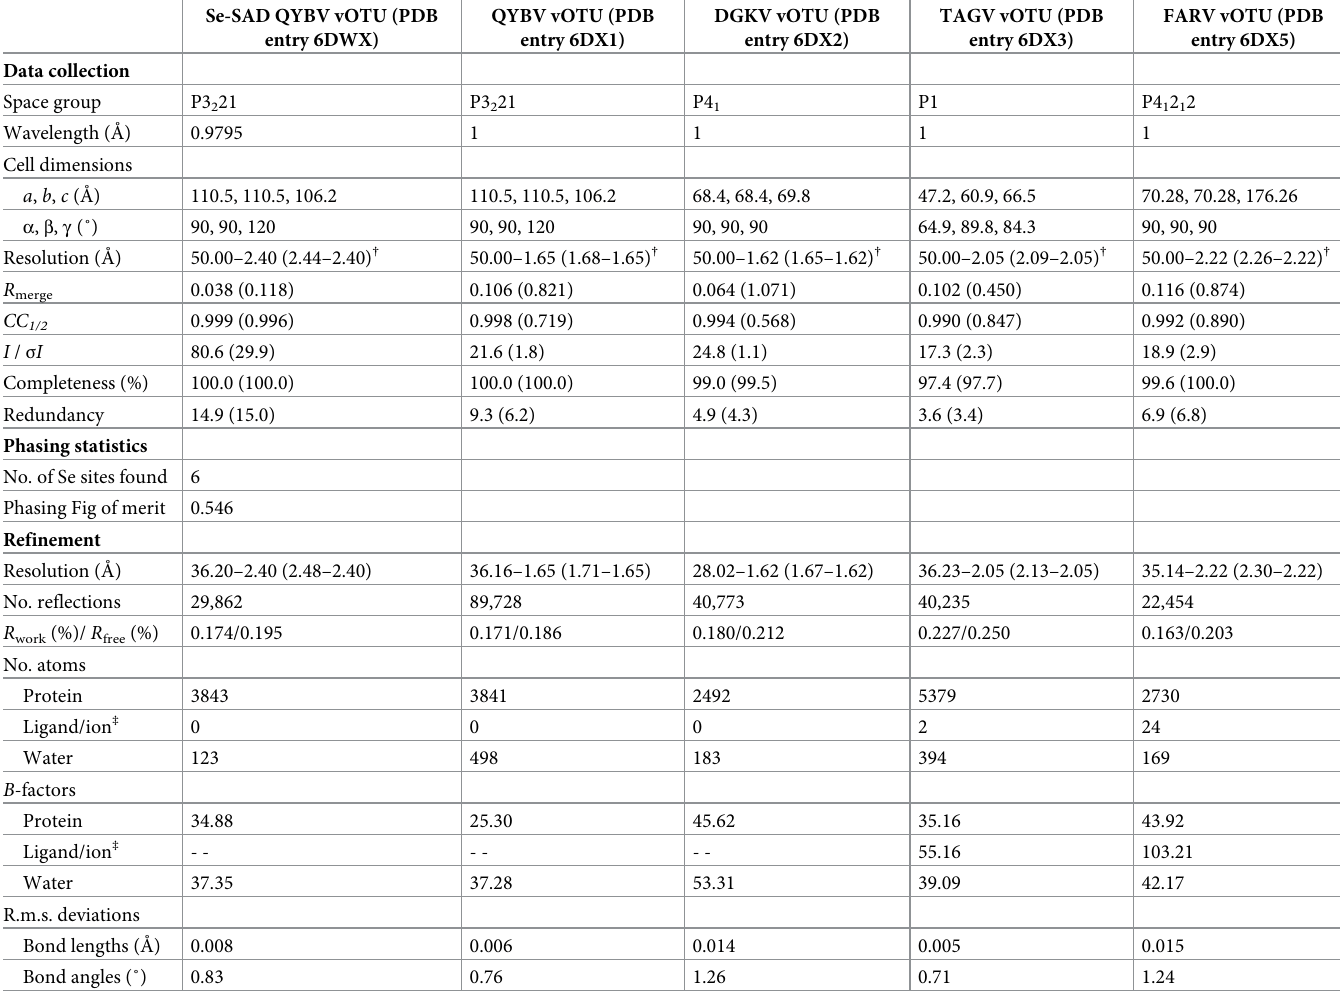
Table 1. Data collection and refinement statistics for vOTU crystal